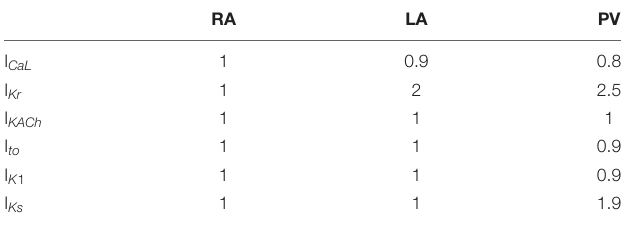
TABLE 1 | Scaling factors of the channels’ conductances to reproduce atrial heterogeneities. RA LA